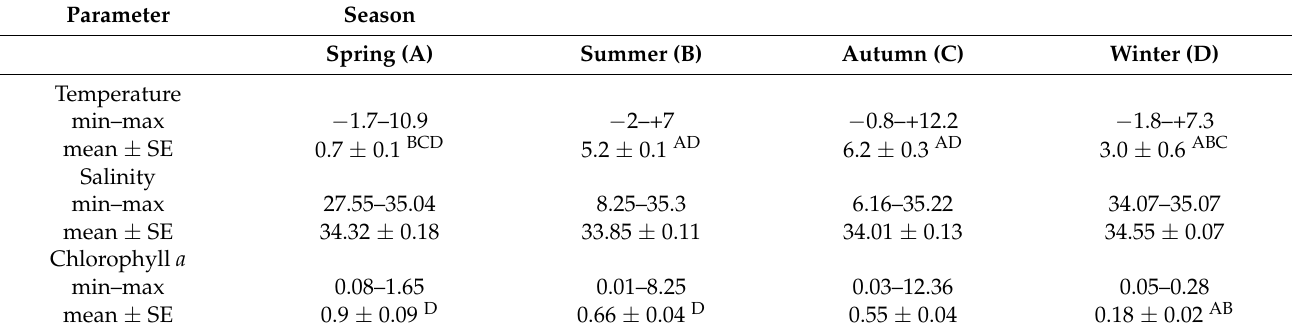
Table 2. Mean SST ( ◦ C), SSS (psu), and Chl-a (mg m –3 ) in the Barents Sea, 1984–2021. Letters show significant differences between seasons (Tukey’s pairwise comparisons, p < 0.05).